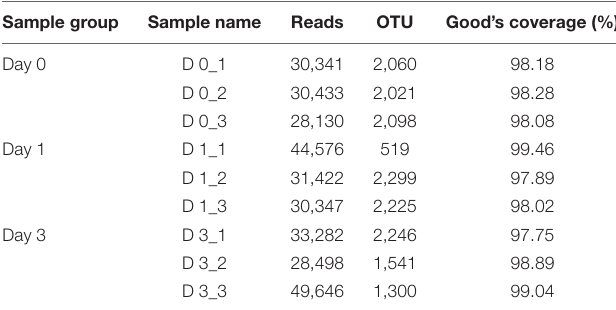
TABLE 1 | Effective sequence numbers, OTUs, and Good’s coverage of clam meat during refrigerated storage at 0, 1, and 3 days. Sample